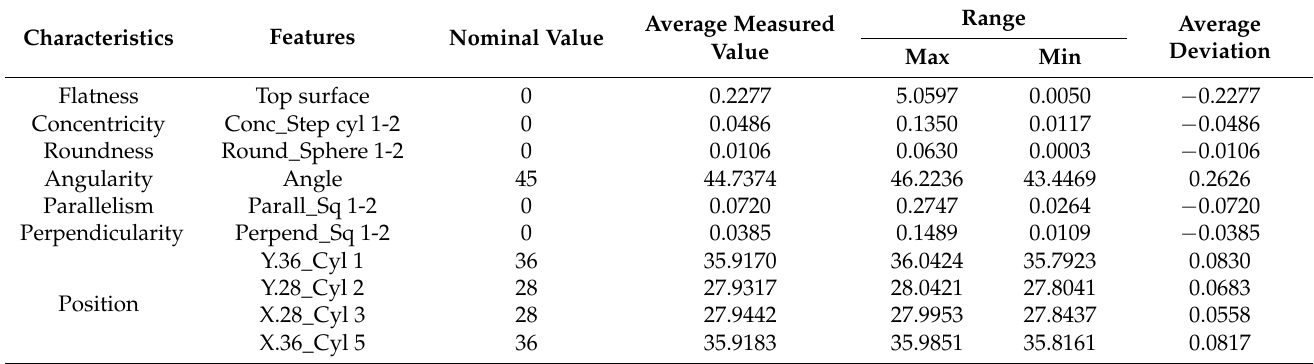
Table 12. Printed patterns measurement results for geometric characteristics, in mm.